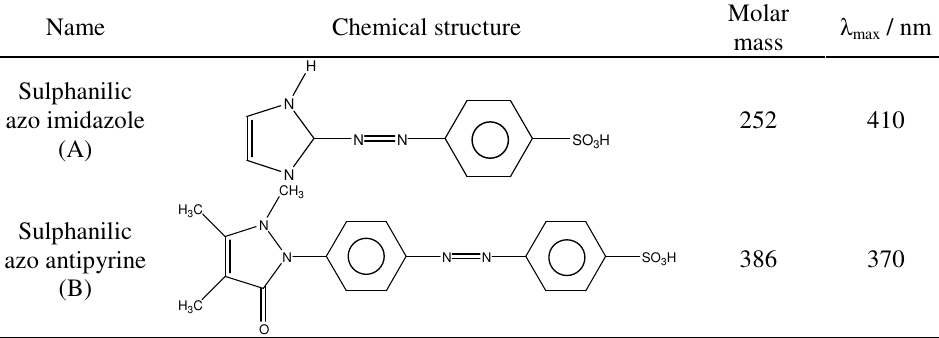
Table 1. Structures, molecular weights and wavelengths of the